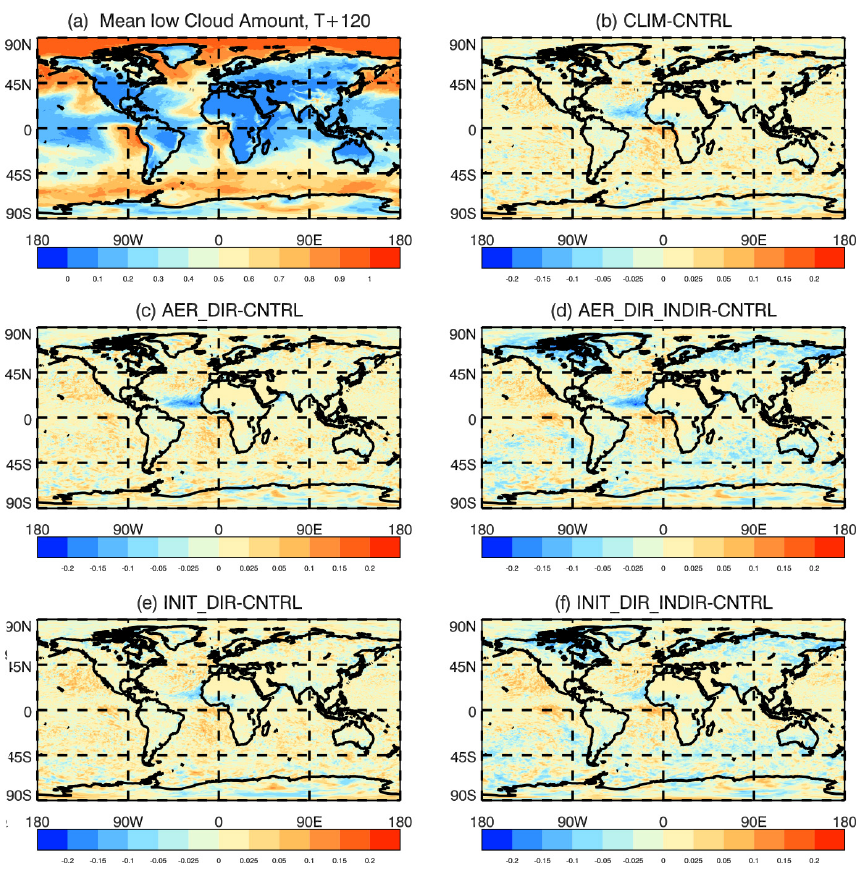
Fig. 15. Impact of different aerosol representations on low cloud amount at T + 120: (a) mean low cloud amount from CNTRL simulation, (b) CLIM-CNTRL, (c) AER_DIR-CNRTL, (d) AER_DIR_INDIR-CNRTL, (e) INIT_DIR-CNTRL and (f)